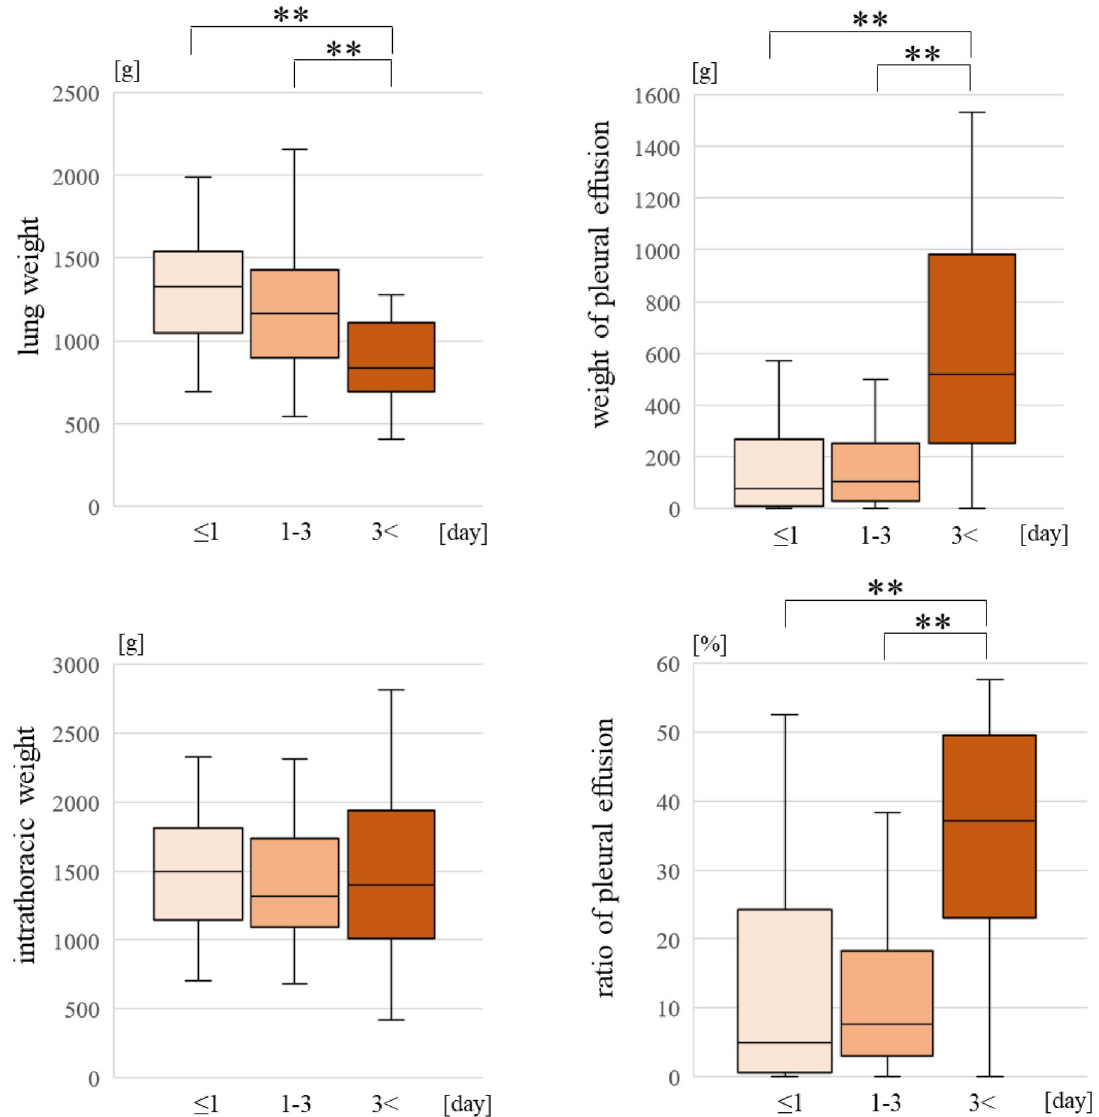
Figure 2. Comparing the parameter for different postmortem intervals.